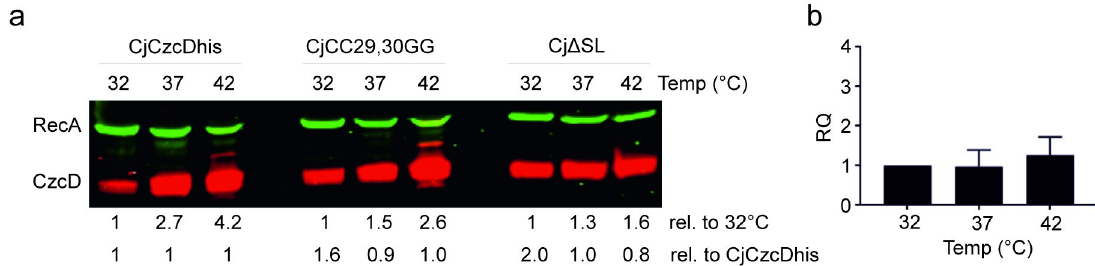
Fig 2. The SL czcD mediates temperature-dependent post transcriptional regulation of CzcD in C . jejuni . a. Western blot analysis of the C . jejuni NCTC11168 CjCzcDhis strain and derivatives with deletion of the SL czcD (Cj Δ SL) and the derepressing mutation CC29,30GG (CjCC29,30GG). Standardised whole cell lysates were probed with anti-RecA (green) as a loading control and anti-histidine (red) to detect CzcD. Cultures were grown for 24 hours in MH broth at the temperatures indicated. All CzcD signals were standardised to the corresponding internal RecA loading control signal and normalised. Relative CzcD quantifications are provided below the blots normalised to the corresponding 32˚C CzcD value for each of the three strains to allow effect of temperature to be quantified (upper row) or to the CjCzcDhis value at each temperature allowing comparison of Cj Δ SL and CjCC29,30GG strains with CjCzcDhis (lower row). These data are representative of at least three replicate experiments. b. RT-qPCR analysis of czcD expression levels for strain CjCzcDhis grown for 24 hours in MH broth at the temperatures indicated. The CT values were normalised against the data at 32˚C. Data are the mean of three biological replicates with standard error indicated. Comparison of ΔΔ Ct mean values by t test gave non-significant p values of 0.90 (37 vs 32˚C) and 0.78 (42 vs